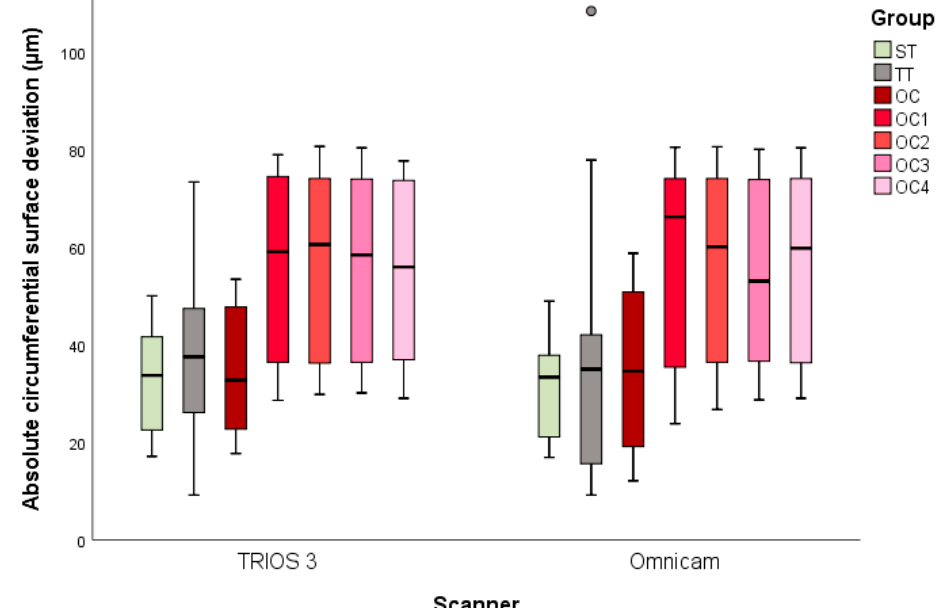
Figure 4. Box and whisker plots of the minimum, maximum, interquartile range, median, and outliers for the absolute circumferential surface deviations.